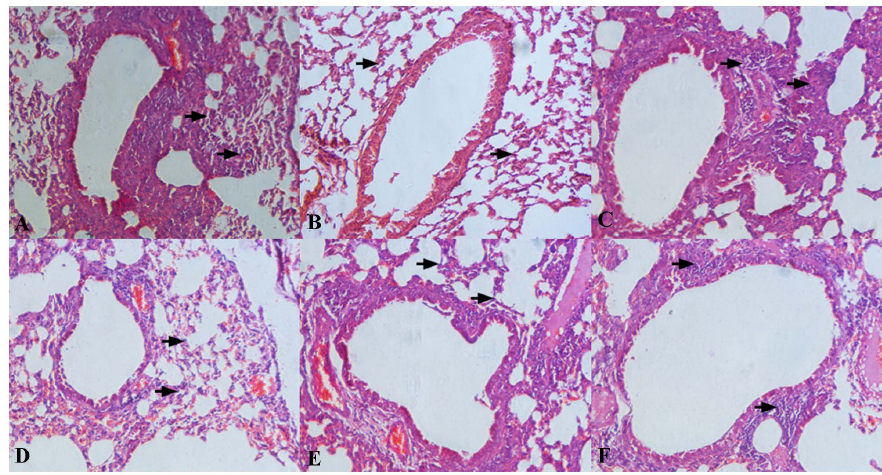
Figure 5. Histological analysis. Representative images (200x) showed the extensive infiltration of inflammatory cells in the lung tissues from the respective groups: Positive group (A), Negative group (B), L. lactis 8148 (C), LL-E (D), LL-I (E), LL-W (F). Inflammatory cells were indicated with black arrows.